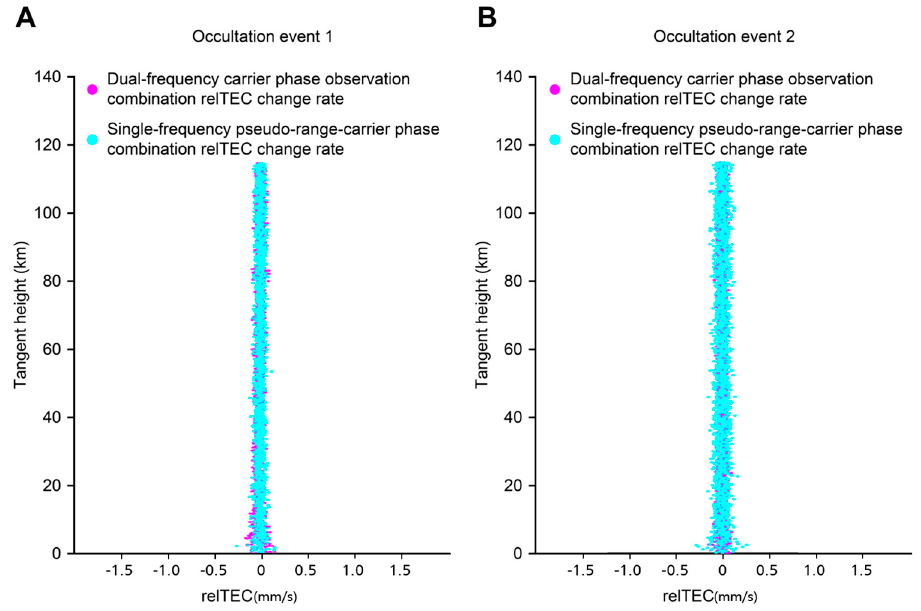
Figure 1. The expression of the relTEC change rate of the single-frequency pseudorange carrier phase combination and the dual-frequency carrier phase combination at different tangent heights, ( A ) is occultation event 1 and ( B ) is occultation event 2.